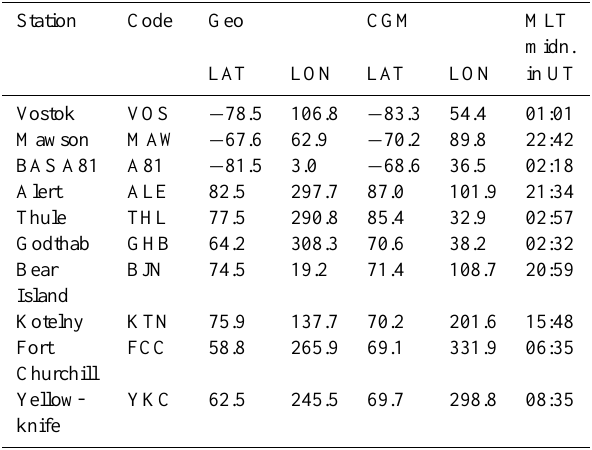
Table 1. Information about observatories.